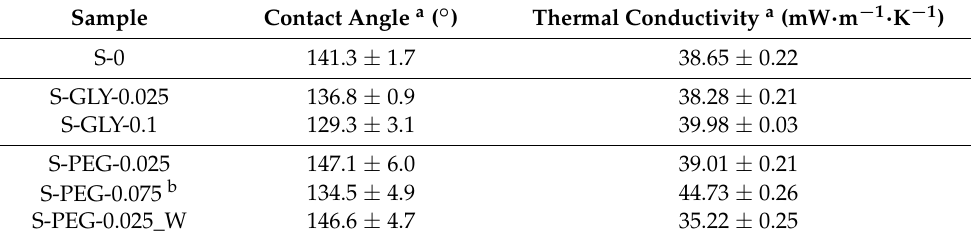
Table 4. Contact angles and thermal conductivities for the synthesized aerogel-like materials.